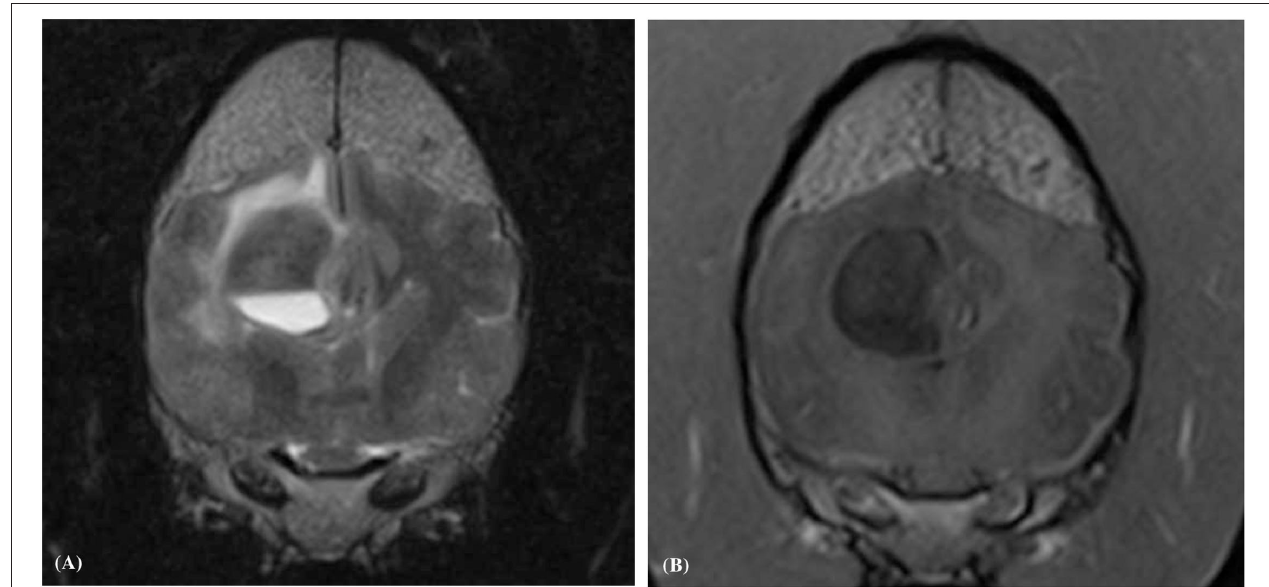
FIGURE 5 | Transverse plane T2-weighted (A) , and T1-weighted post contrast (B) , images of a dog (Case 3) with an intracranial intra-axial hematoma affecting the white matter of the right fronto-parietal lobe. In this section of the lesion there is a well-defined fluid-fluid lesion. The dependent and ventral region is T2-weighted hyperintense and T1-weighted hypointense, and the dorsal region was T2-weighted hypointense and T1-weighted isointense relative to gray matter. This imaging feature was only observed in two of the hematoma